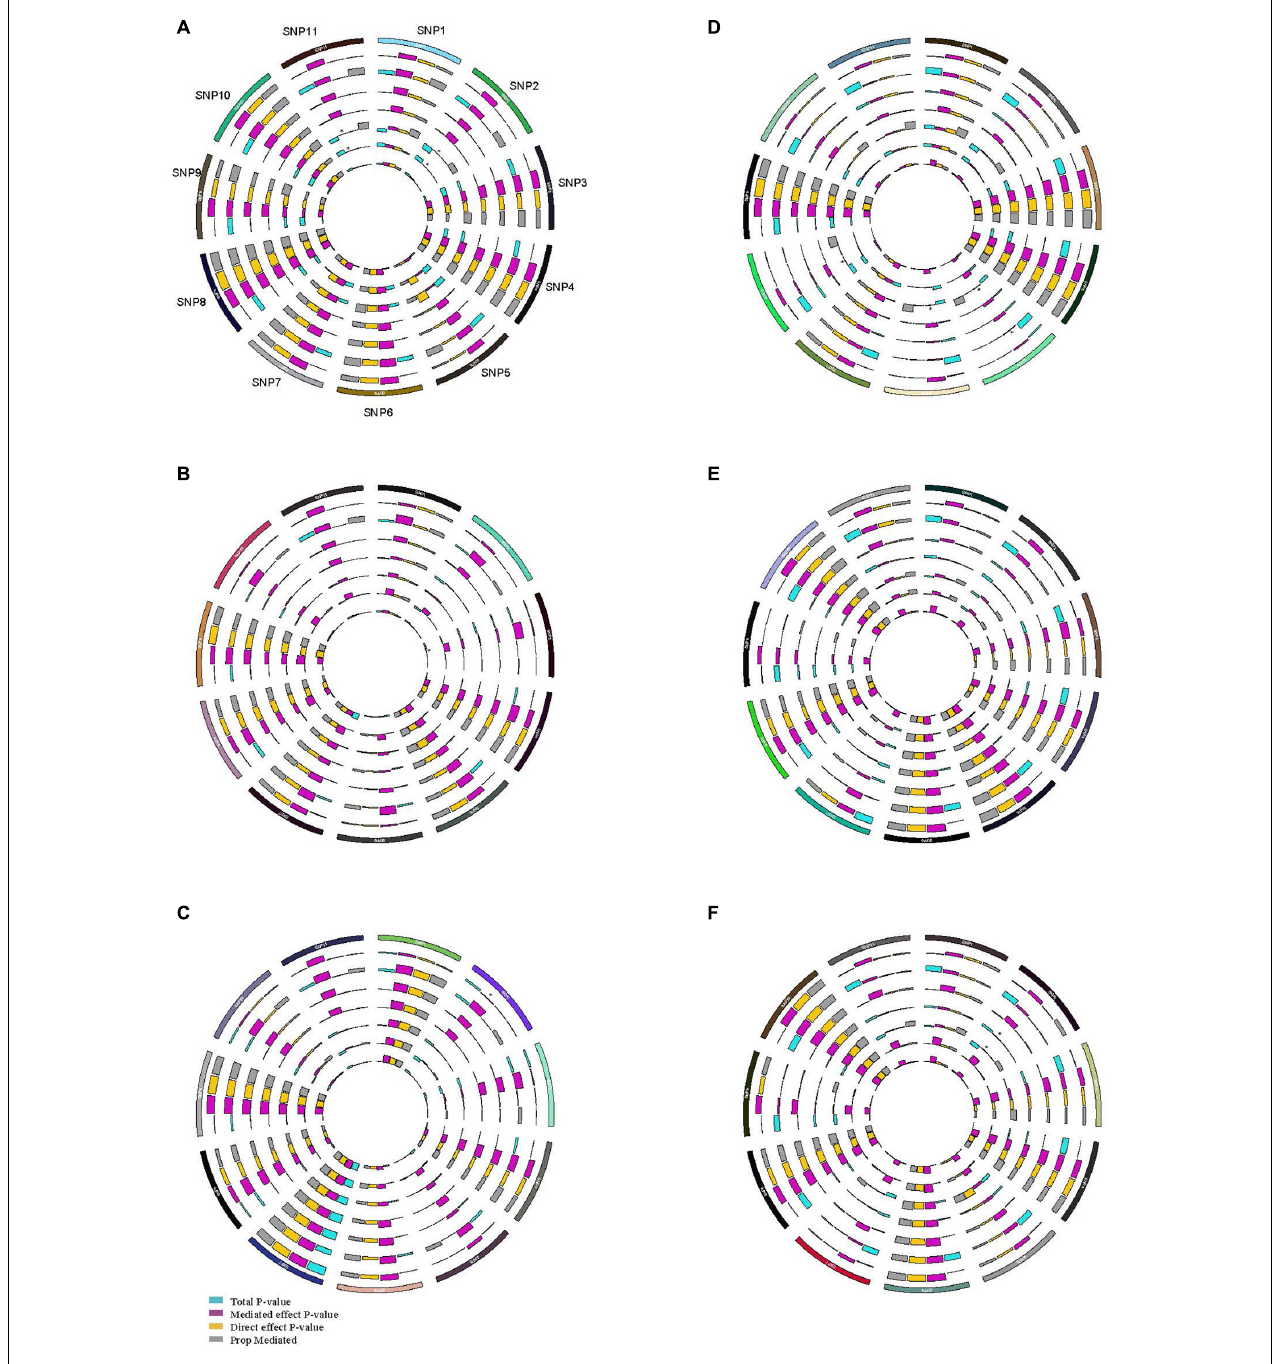
FIGURE 3 | Circos plot showing the mediation model of the SNP, risk factors, and SSBP phenotypes. SNP, risk factors, and SBP increase during acute salt loading (A) ; SNP, risk factors, and DBP increase during acute salt loading (B) ; SNP, risk factors, and MAP increase during acute salt loading (C) ; SNP, risk factors, and SBP decease during diuresis shrinkage (D) ; SNP, risk factors, and DBP decease during diuresis shrinkage (E) ; SNP, risk factors, and MAP decease during diuresis shrinkage (F) ; SNP1 BCAT1/rs7961152, SNP2 PRKG1/rs7897633, SNP3 SLC8A1/rs11893826, SNP4 AGTR1/rs2638360, SNP5 CYBA/rs4673, SNP6 SELE/rs6427212, SNP7 CYP4A11/rs1126742, SNP8 SELE/rs5368, SNP9 VSNL1/rs16983422, SNP10 SELE/rs4656704, SNP11 PRKG1/rs1904694; The outer layer to the inner of ring were BMI, WHR, TC, TG, HDLC, LDLC, FBG, respectively. Purple indicates the mediated effect p -value; orange indicates the direct effect p -value; blue indicates the total p -value; grey indicates the mediation proportion; *mediated effect P < 0.05.